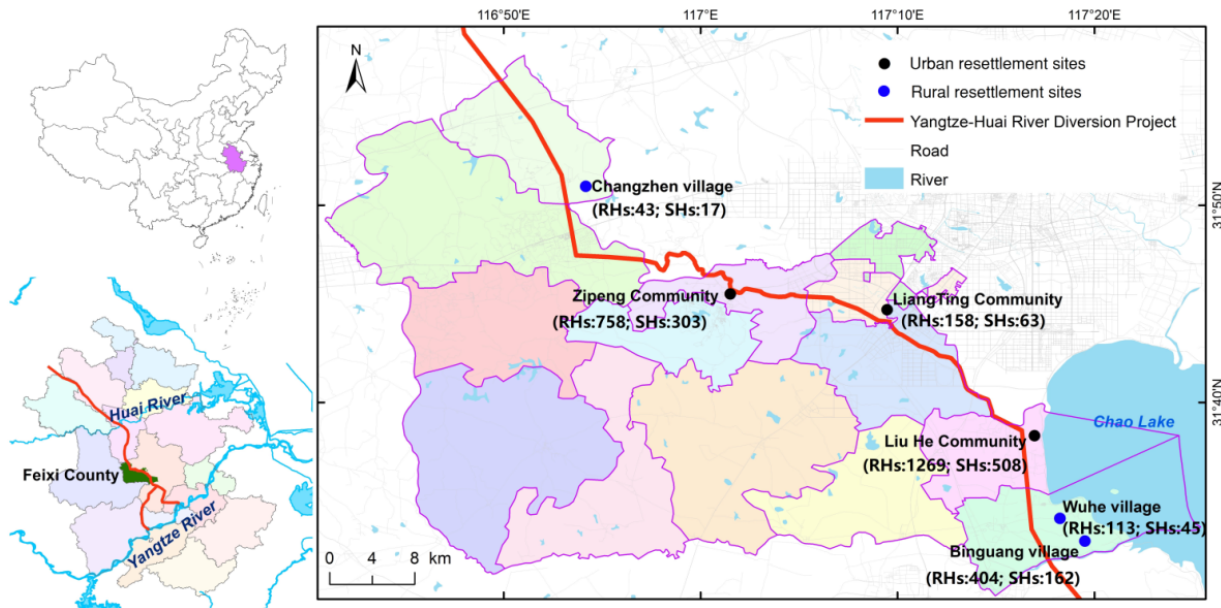
Figure 1. Geographical map of resettlement sites. (RHs = Relocated households; SHs = Sample households).